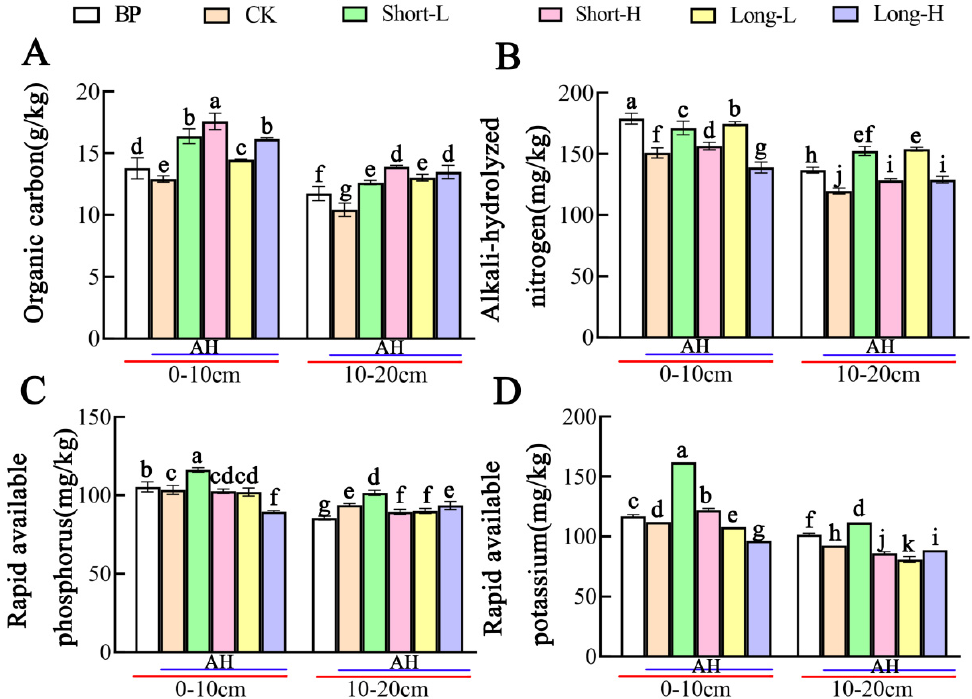
Figure 4. Variation trends of the nutrient contents in different soil layers under different wheat straw mulching treatments. Short: 10 cm wheat straw by mechanical cutting. Long: wheat straw without any treatment. BP, before planting; AH, after harvest; CK, soil layer without any treatment; L, 11,250 kg/ha straw mulching; H, 18,750 kg/ha straw mulching. ( A ), the organic carbon of the soil; ( B ), the alkali-hydrolyzed nitrogen of the soil; ( C ), the rapid available phosphorus of the soil; ( D ), the rapid available potassium of the soil. Data are means ± SD (n = 3). The different lowercase letters in the figure indicate significant differences between the different treatments based on the bidirectional ANOVA tests ( p <